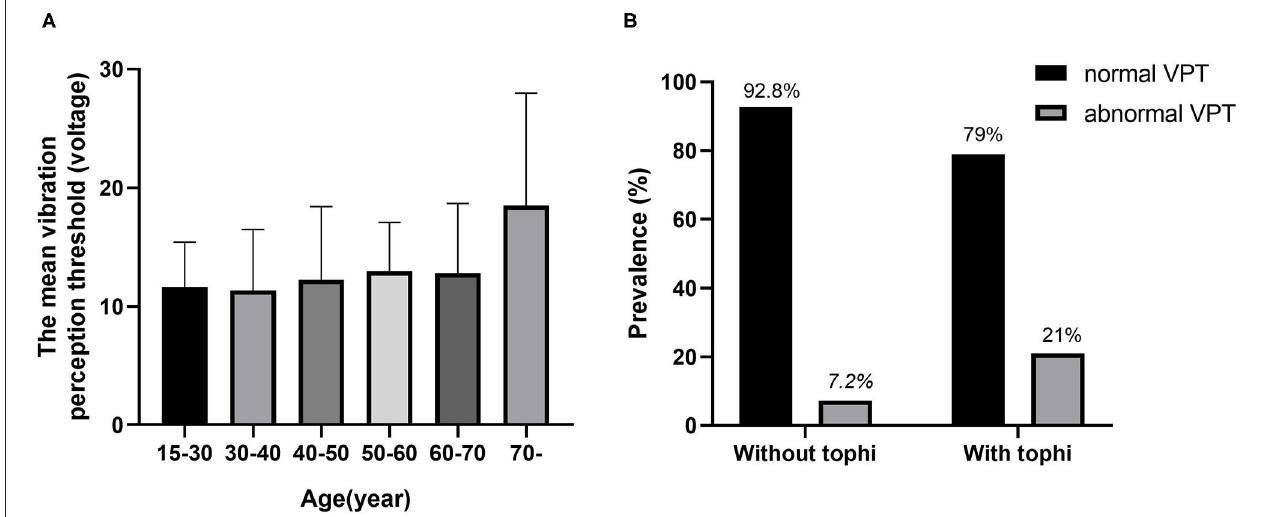
FIGURE 1 | The relationship between vibration perception threshold (VPT) and age and tophi. (A) The mean VPT levels according to the age categories. (B) Comparison of the prevalence of normal VPT and abnormal VPT between gout patients with and without tophi.